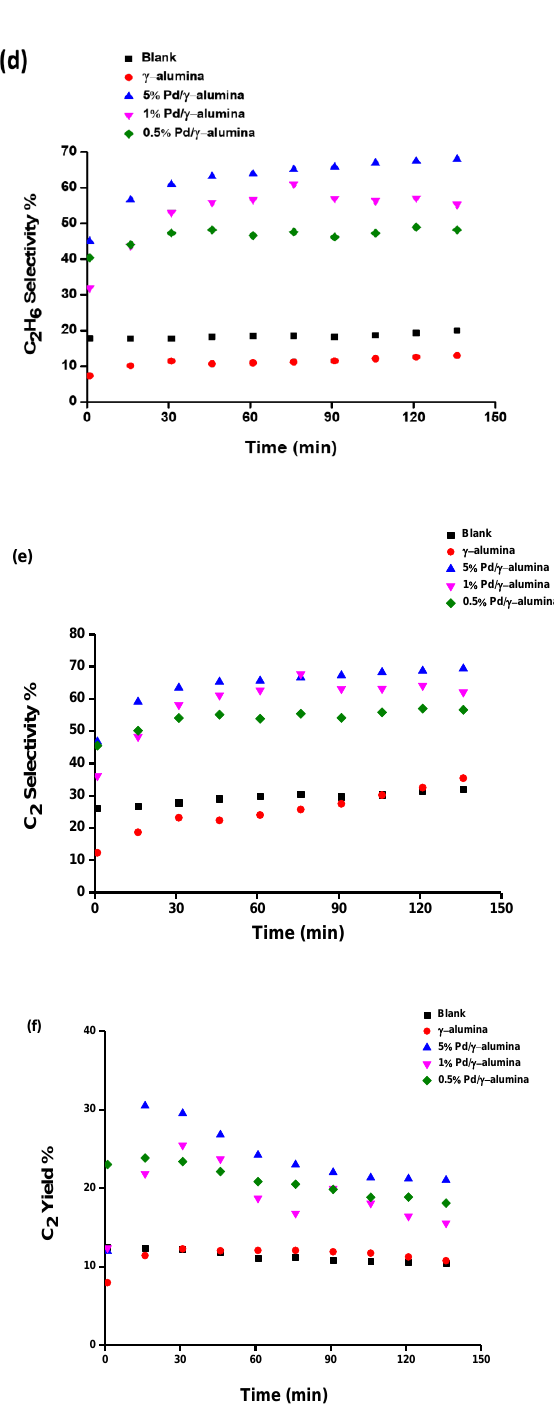
Figure 2. Effect of packing the dielectric barrier discharge (DBD) plasma reactor with γ-alumina and Pd/γ-alumina with different loadings of Pd (0.5, 1, 5 wt%): ( a ) methane conversion, ( b ) acetylene selectivity, ( c ) ethylene selectivity, ( d ) ethane selectivity, ( e ) C 2 selectivity, ( f ) C 2 yield.